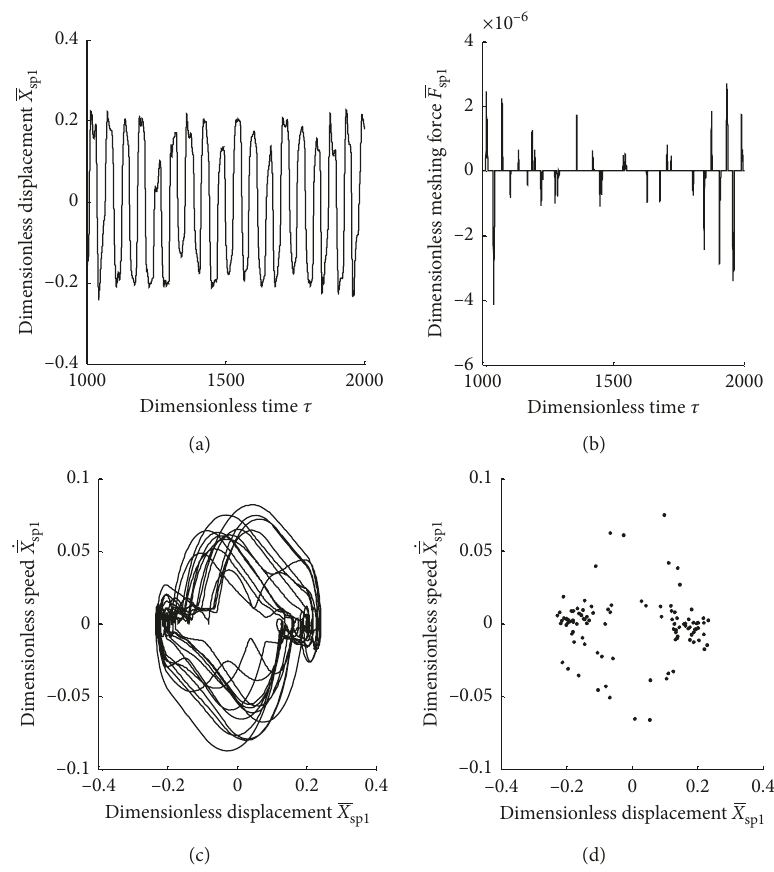
Figure 5: Process diagrams of response, phase diagram, and Poincar´e section under b � 20 μ m for differential stage. (a) Time process diagram of displacement response. (b) Time process diagram of meshing force response. (c) Phase diagram. (d) Poincar´e